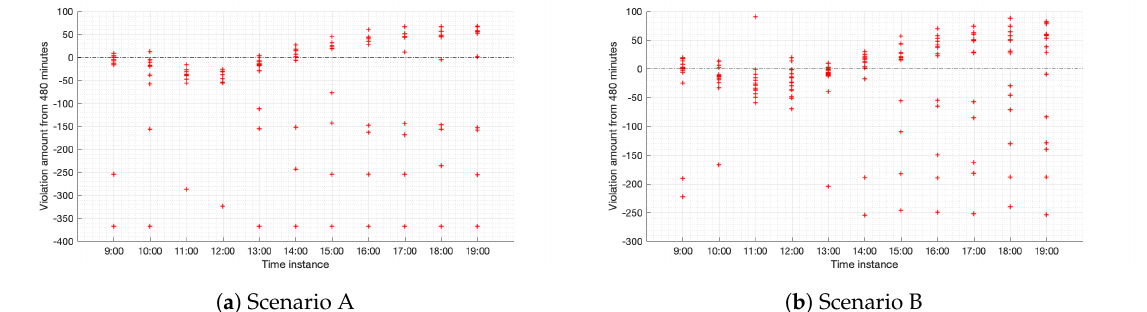
Figure 10. Transferring route solution from a fixed time instance to actual traffic time when the working time limit in the fixed time instance was set to 480